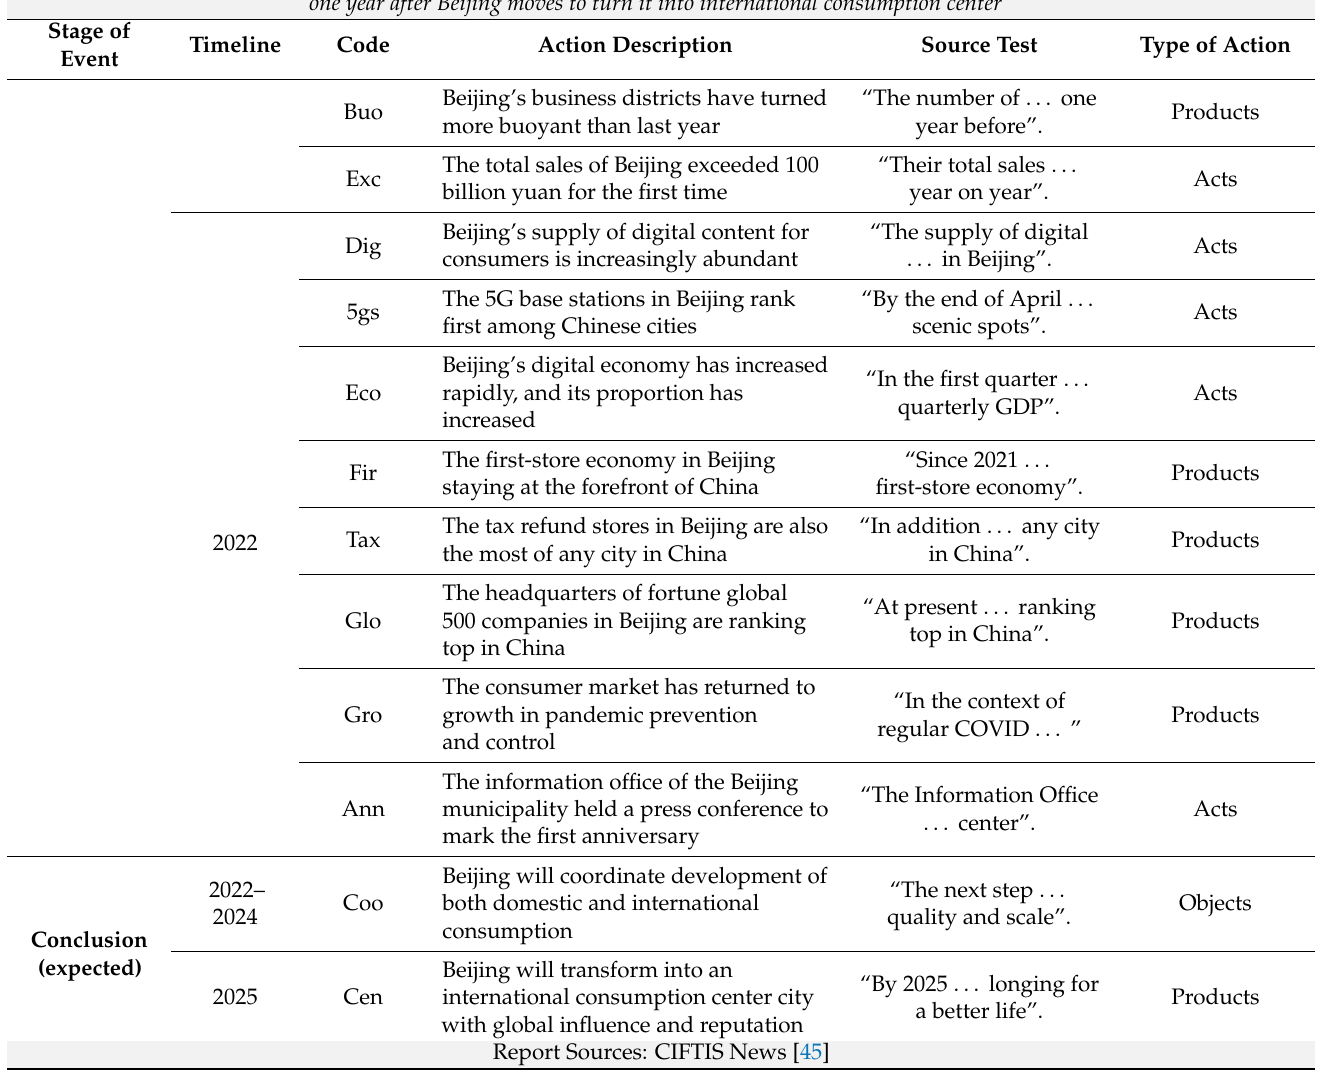
Table A2. The deconstruction and coding table of narrative